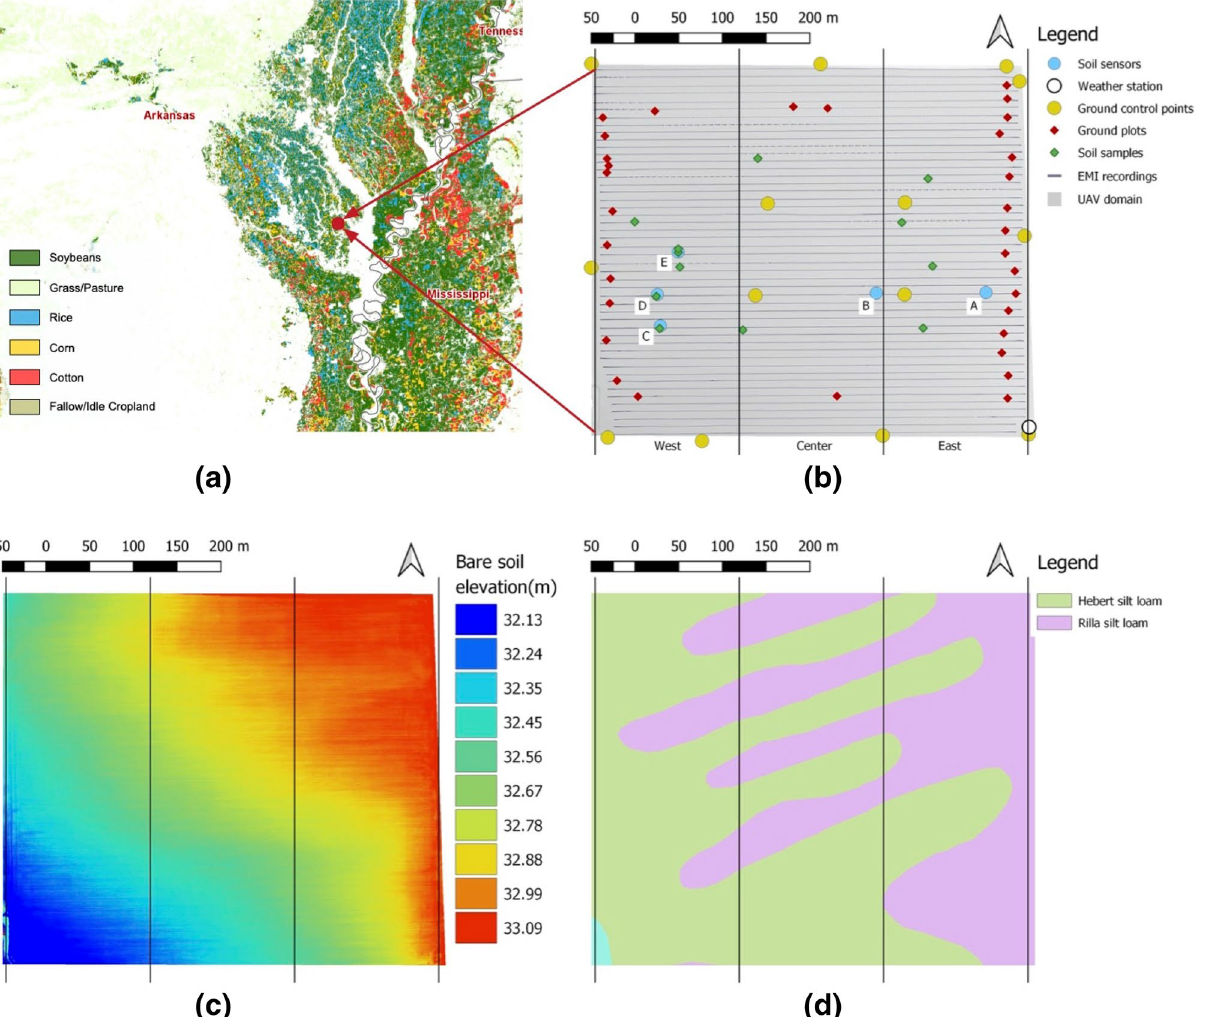
Figure 1. Study area located in Humphrey, Arkansas: ( a ) map produced by cropScape (USDA) showing part of the Delta region with the main agricultural land covers; ( b ) map of the field under study reporting the locations of the ground data collection; ( c ) map showing the topographic elevation derived by an UAV-based DEM, acquired acquisition prior to planting; ( d ) gSSurgo map provided by USDA, showing the soil types. Black vertical lines separate the east, center, and west sections used in the statistical analysis. Maps made with QGIS (v 3.6, https:// www. qgis. org) 36